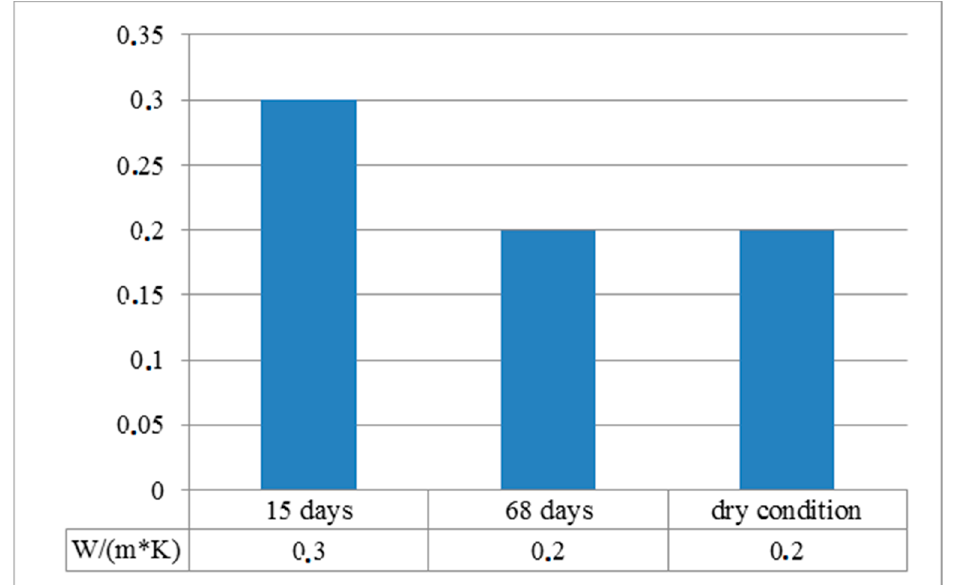
Figure 9. Thermal conductivity results of eco-plaster. Comparison at 15 days, 68 days and in dry condition.